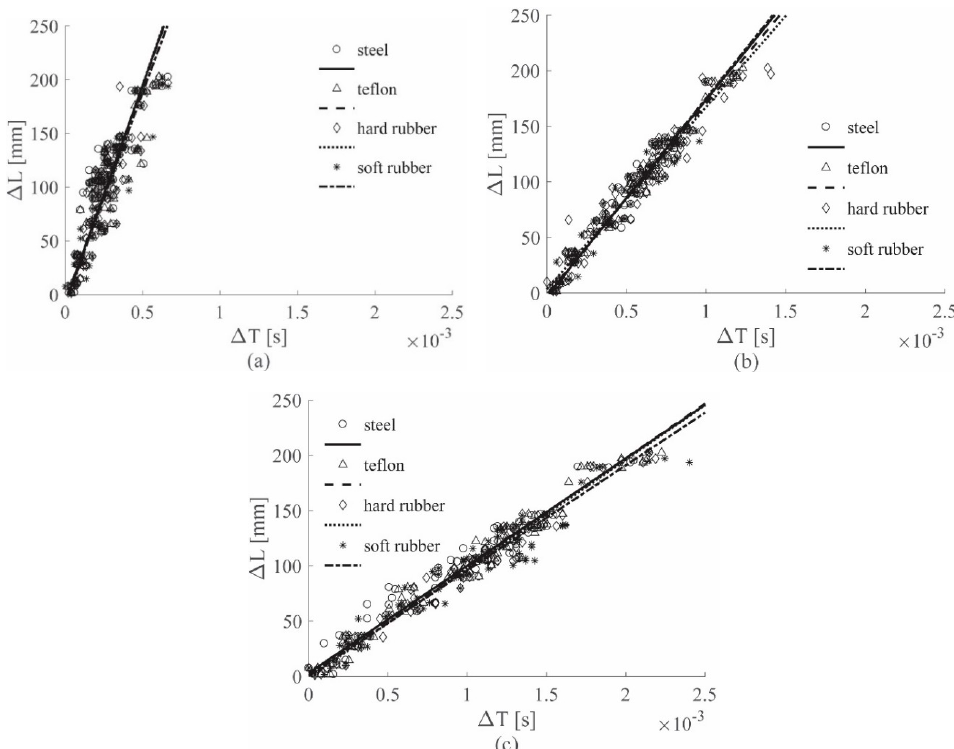
Figure 8. ( Δ L – Δ T ) visual approach results for the ACC sensors, Al plate, all tips, filtered with the 0–4912 Hz filter ( a ), 0–2000 Hz filter ( b ) and 0–619 Hz filter ( c ).